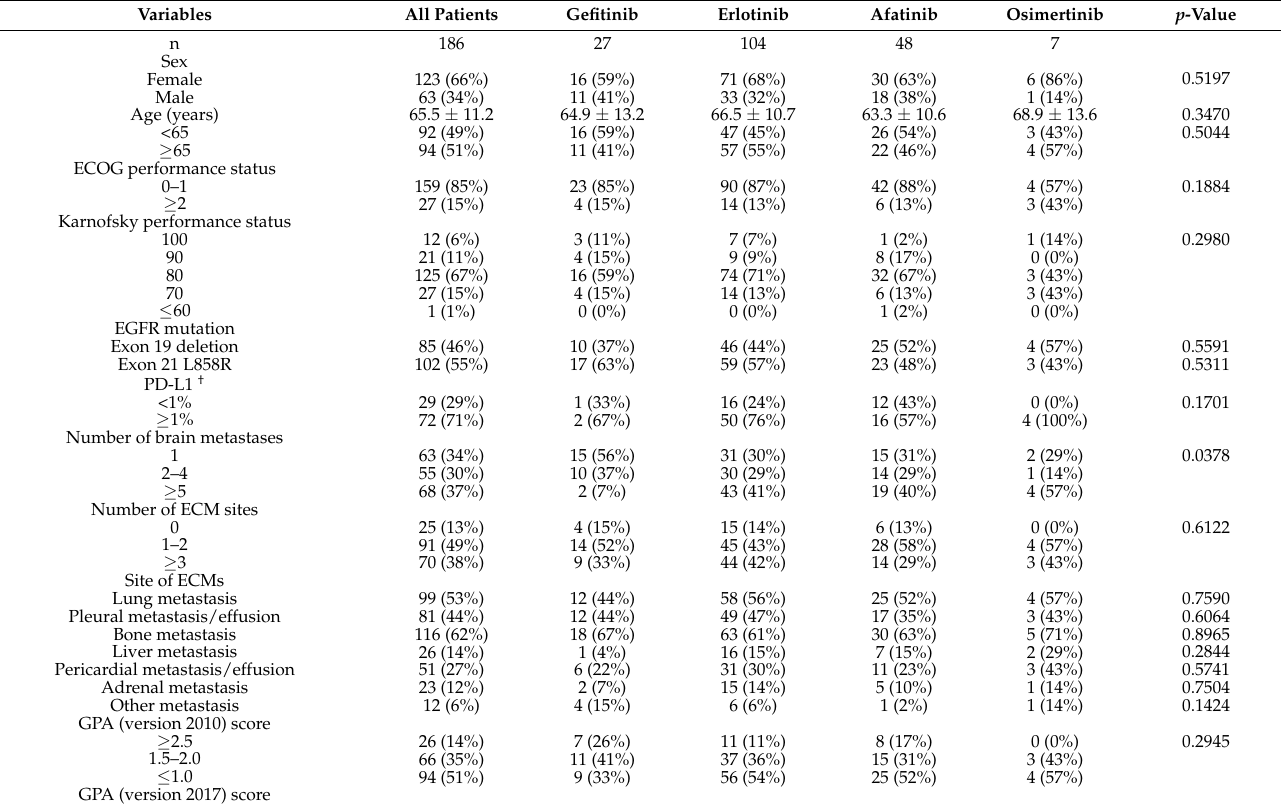
Table 1. Baseline characteristics of the study